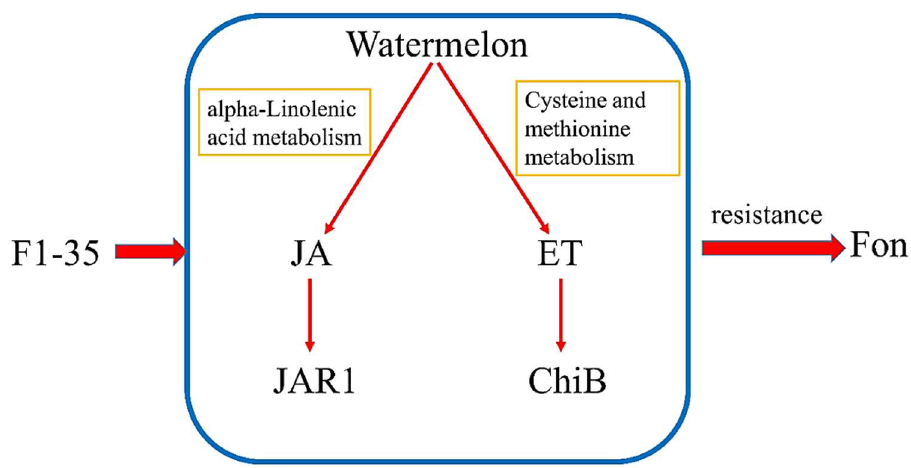
Figure 4. A summary of the mechanism of F1-35 protection of watermelons against FON.